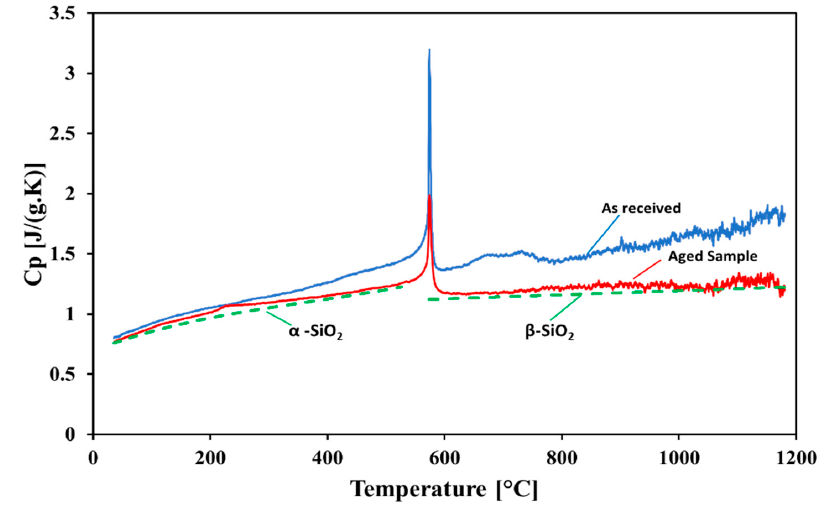
Figure 10. Specific heat measurements of the red sand sample.